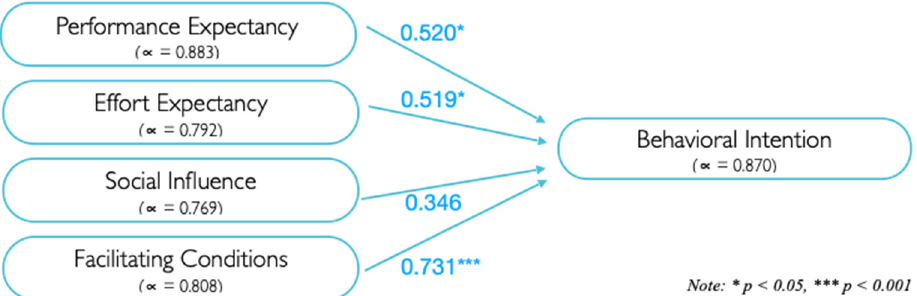
Figure 6. Correlation between the different dimensions of the UTAUT at D + 21—SHERPAM project. The main difference is related to expected performance: this relationship is significant at D + 21, whereas it was not at D0. Moreover, at D + 21 the same correlation between Effort Expectancy/Behavioral Intention and Facilitating Conditions/Behavioral Intention as at D0 was found. There was no effect of moderators on the results at D + 21. Table 5. Correlation Matrix UTAUT dimensions—SHERPAM project D + 21.